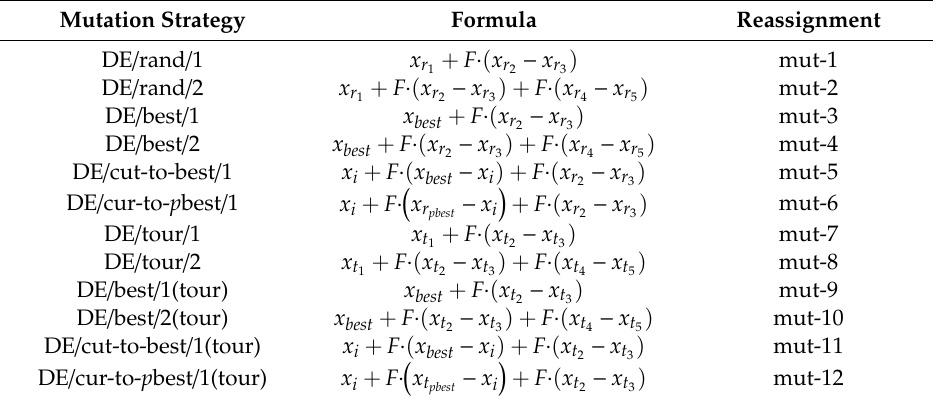
Table 8. Mutation